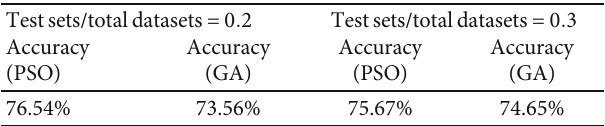
Table 6: Evaluation accuracy of di ff erent optimization algorithms on the test set.